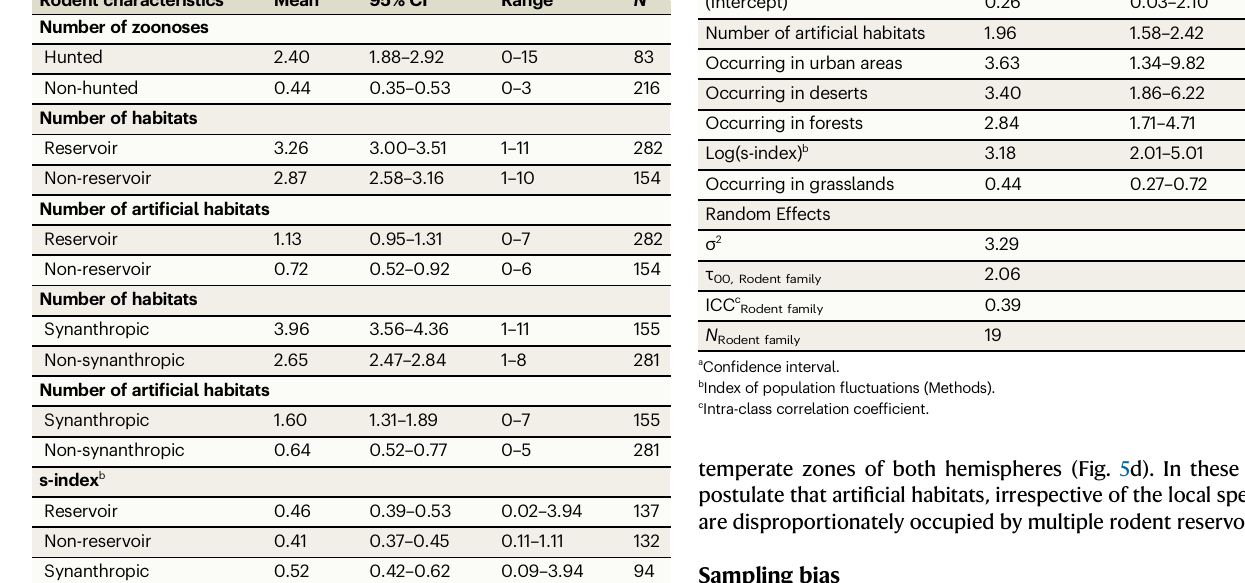
Table 2 | Summary of rodent characteristics divided by rodent group with respect to hunting, reservoir status, and synan- thropic behaviour